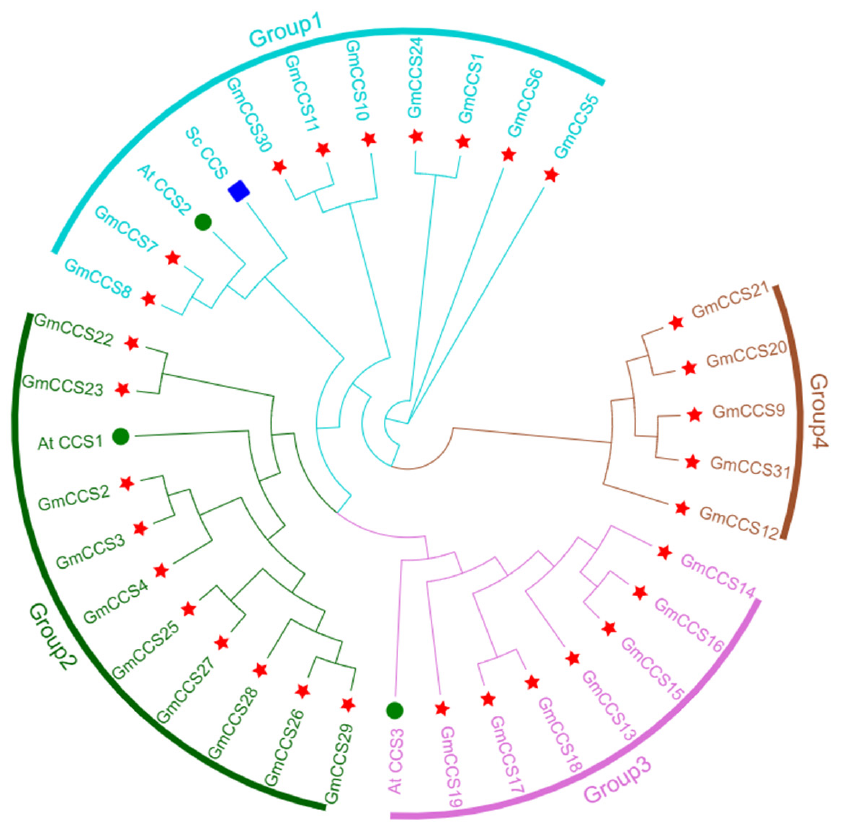
Figure 2. Phylogenetic tree of CCS proteins in Glycine (G.) max , Arabidopsis thaliana and Saccharomyces cerevisiae . Four subgroups were classified with different colors, and their names are marked in the corresponding positions. The circle, five-pointed star, and square text indicate Arabidopsis thaliana , Glycine (G.) max and Saccharomyces cerevisiae , respectively.